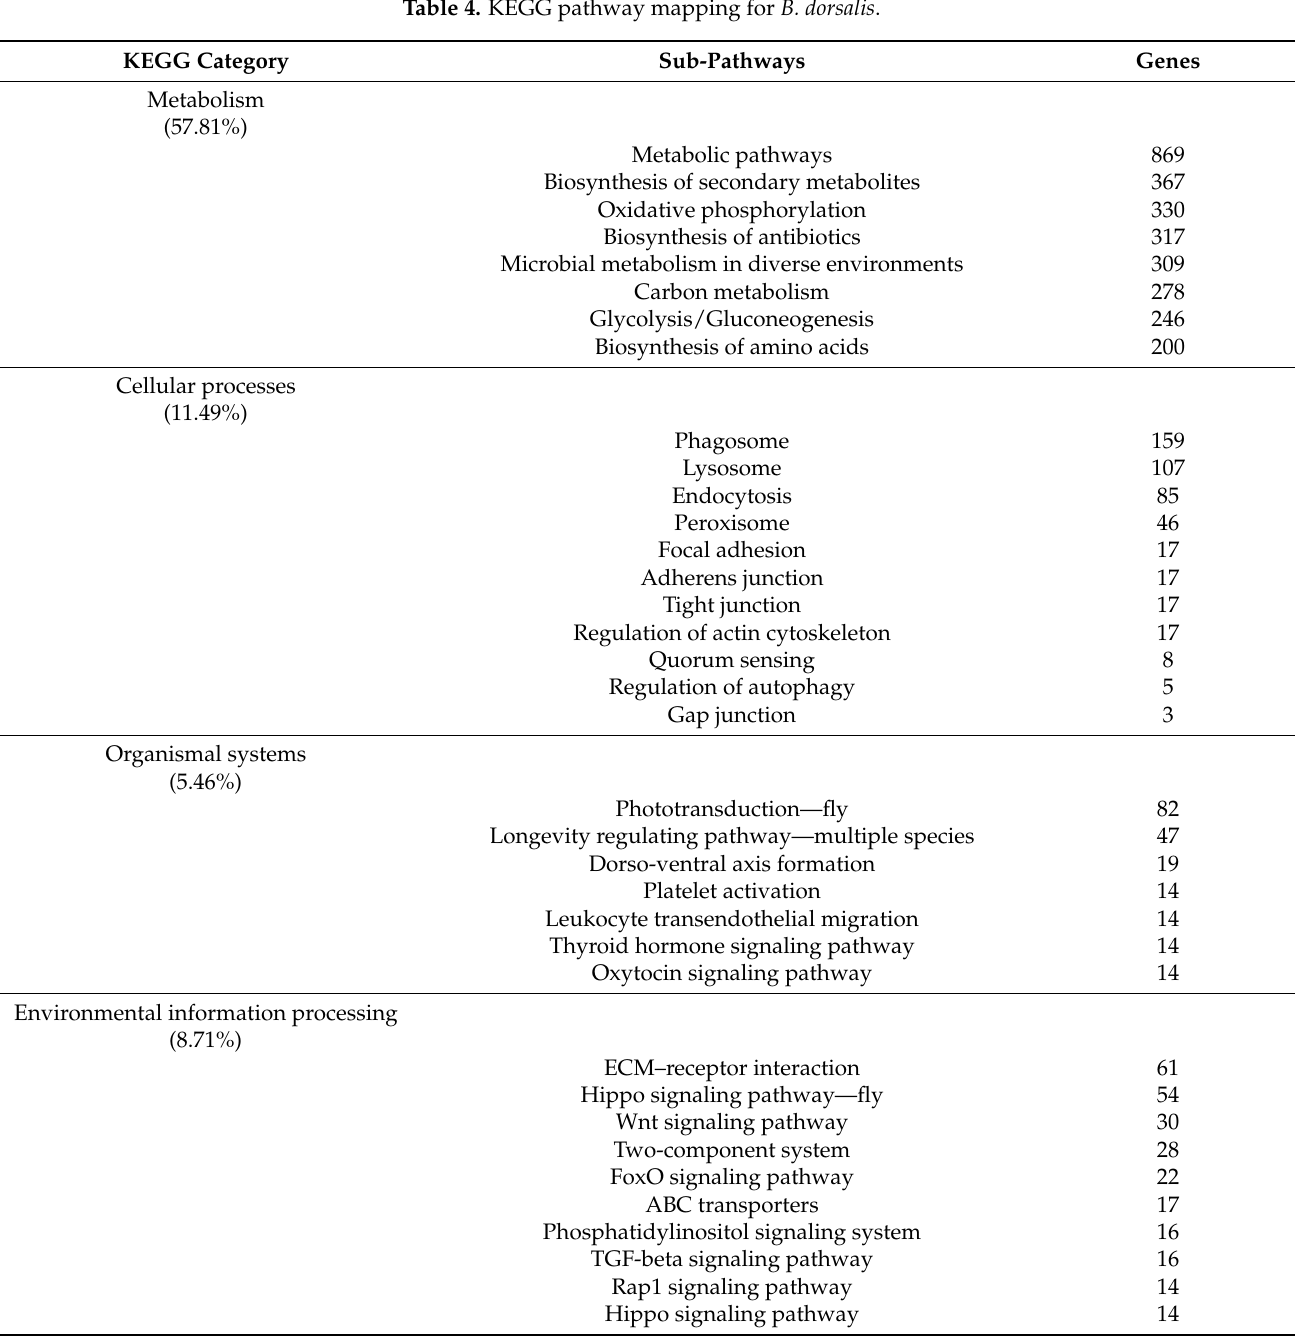
Table 4. KEGG pathway mapping for B. dorsalis